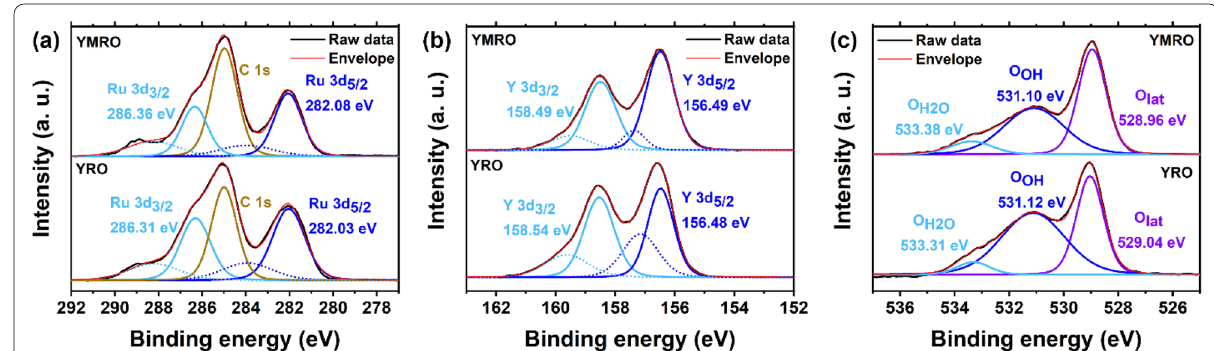
Fig. 6 XPS spectroscopy of the a Ru 3d, b Y 3d and c O 1 s regions of YMRO and YRO